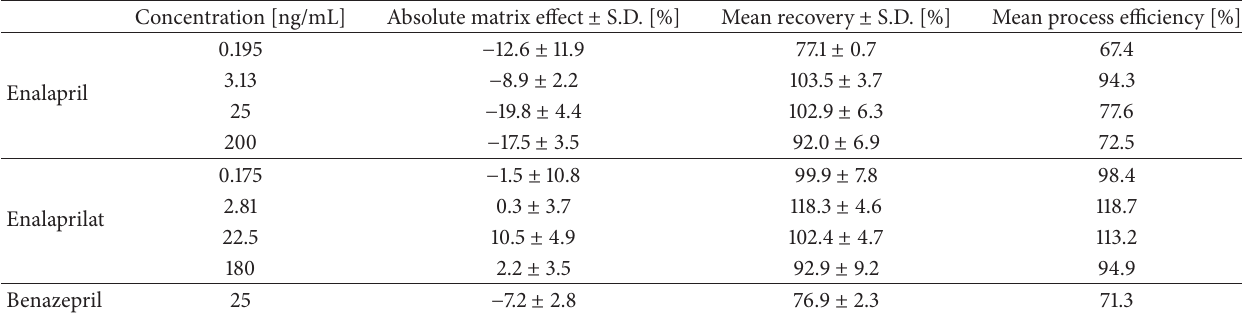
Table 1: Results for recovery, absolute matrix effect, and process efficiency.